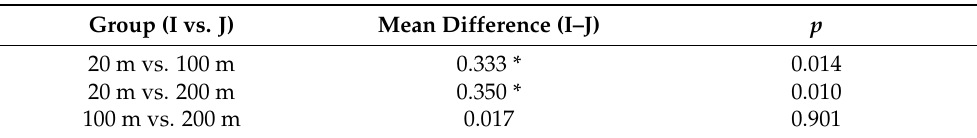
Table 15. Post hoc (LSD) multiple factors comparison analysis of impacts of different viewing distances on perceived anxiety.